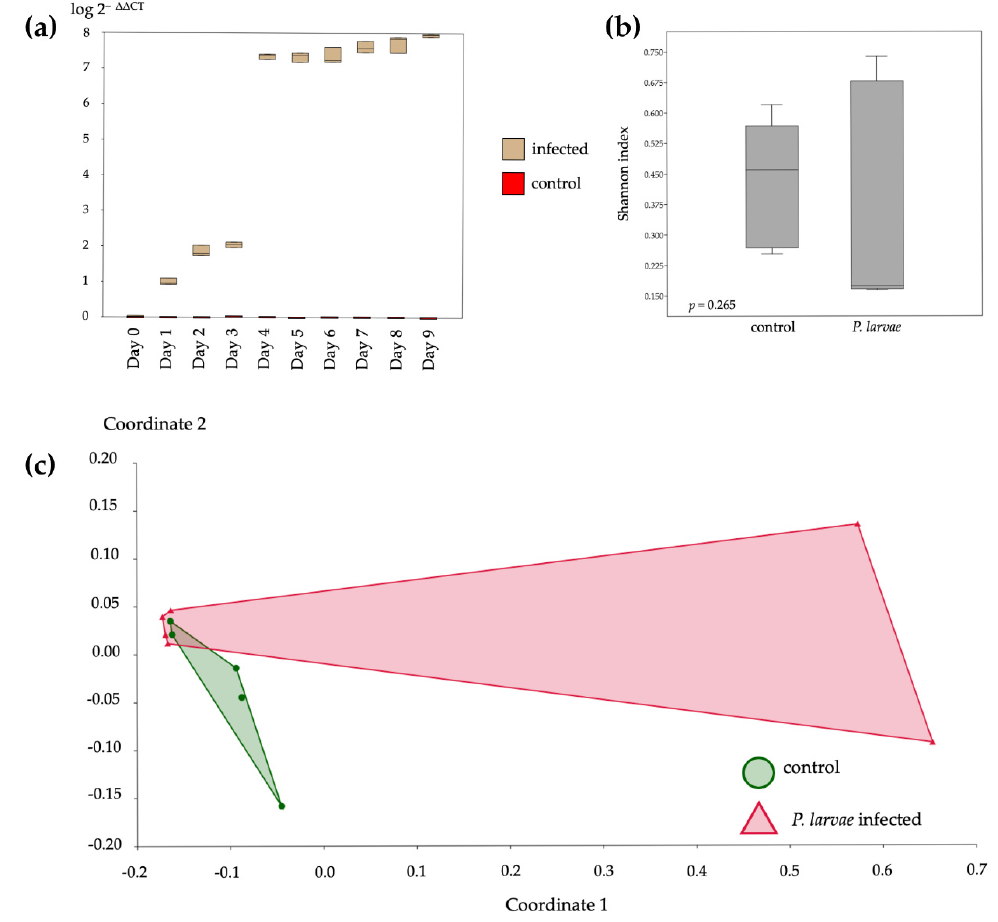
Figure 1. P. larvae infection level and diversity analysis of bacterial communities in honey bee larvae. The expression level, calculated by 2 −∆∆ CT method, of P. larvae expression in larvae from day 0 to 9, showing that the P. larvae infection was significantly increased from day 3 to 4 and then slightly increased until day 9 ( a ). Alpha diversity, indexed with the Shannon parameter, of bacterial communities of control and infected bees that were not significantly different ( t = 1.1817, p = 0.265) ( b ). The nonmetric multidimensional scaling (NMDS) analysis of bacterial communities between the control and infected groups of honeybees showed that the bacterial communities of P. larvae -infected were not significantly different from the control (F = 2.367, p = 0.2447), with a stress value of 0.0127 ( c ).